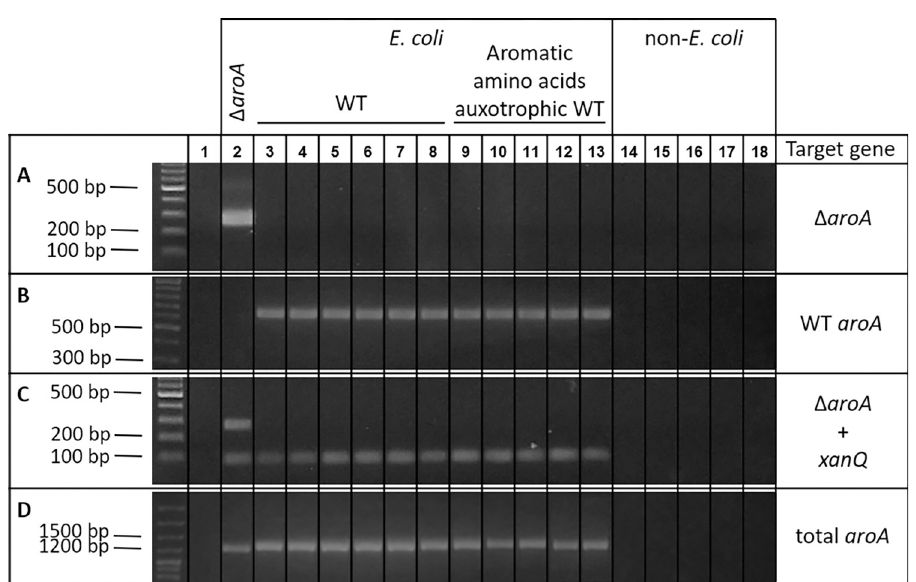
Fig 2. Discrimination of the Δ aroA vaccine strain from other E . coli strains and non- E . coli strains using PCR. The specificity of the primers targeting either the E . coli Δ aroA gene (A), the WT E . coli aroA gene (B), the previously published primers targeting both the WT and Δ aroA gene (total aroA ) (D) or simultaneous detection of the Δ aroA and xanQ gene (C), was screened against a total of 132 E . coli strains and 7 non- Escherichia strains. (A) PCR specific for the Δ aroA gene. Amplification only occurred for the vaccine strain, while none of the commensal E . coli strains or non- Escherichia strains was amplified. The picture shows the results from primer pair aroA _3, which results in a band at 281bp when the aroA mutation is present. All other tested Δ aroA specific primers showed the same specificity. (B) The aroA primers targeting the WT gene ( aroA _WT) result in a band at 660 bp in commensal E . coli , whereas no band occurred when the aroA mutation was present or in the non- Escherichia strains. (C) Duplex PCR with aroA _3 and xanQ _2 primers. The E . coli -specific xanQ primers result in a band at 97 bp, whereas the band at 281 bp indicates Δ aroA . Only for the Δ aroA E . coli strain, the two bands are present. (D) Primer pair aroA _LR (La Ragione et al., 2013, Table 1) is not specific for the Δ aroA mutation and results in an amplicon of 1236 bp for wild type E . coli , or 1161 bp for the Δ aroA vaccine strain. The pictures show a representative selection of the total number of strains used to assess the primer specificity. Samples: 1: blank control 2: E . coli O78:K80 Δ aroA (vaccine strain), 3: E coli O78:K80 WT, 4: E . coli Nissle 1917, 5: APEC_1 (chicken intestine), 6: APEC_2 (turkey intestine), 7: APEC019 (chicken intestine), 8: APEC023 (chicken intestine), 9: 220115–1 (chicken intestine, aromatic amino acid auxotrophic E . coli ), 10: 220115–10 (chicken intestine, aromatic amino acid auxotrophic E . coli ), 11: 06114–21 (chicken intestine, aromatic amino acid auxotrophic E . coli ), 12: 7-35s (chicken intestine, aromatic amino acid auxotrophic E . coli ), 13: 3-44s (chicken intestine, aromatic amino acid auxotrophic E . coli ), 14: Salmonella Enteritidis, 15: Salmonella Typhimurium, 16: Clostridium perfringens NE18, 17: Clostridium perfringens CP20, 18: Bacillus subtilis DSM 29784. The complete list of tested strains can be found in S1 Table. Electrophoresis was performed on 1.5% agarose gel. GeneRulerTM 100 bp Plus DNA Ladder was used as a molecular weight marker.